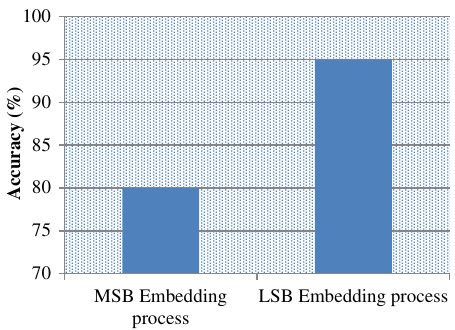
Fig. 12. Accuracy analysis of LSB and MSB embedding process.